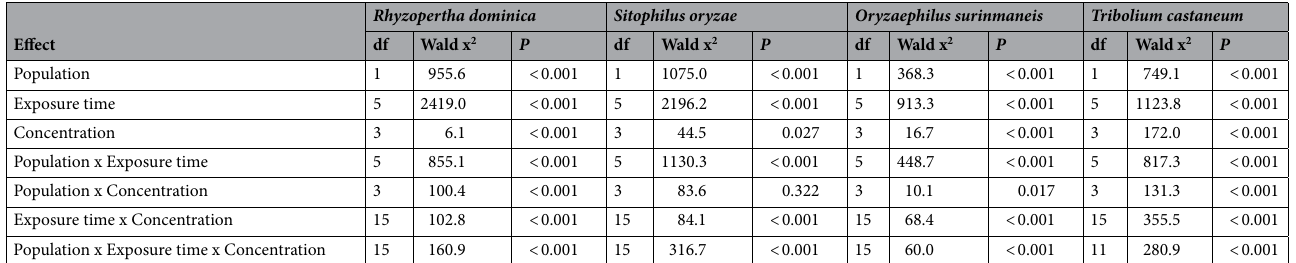
Table 4. Generalized linear model showing the effects of different exposure times and concentrations (500, 1000, 2000 and 3000 ppm) for post exposures, for each species and population tested.